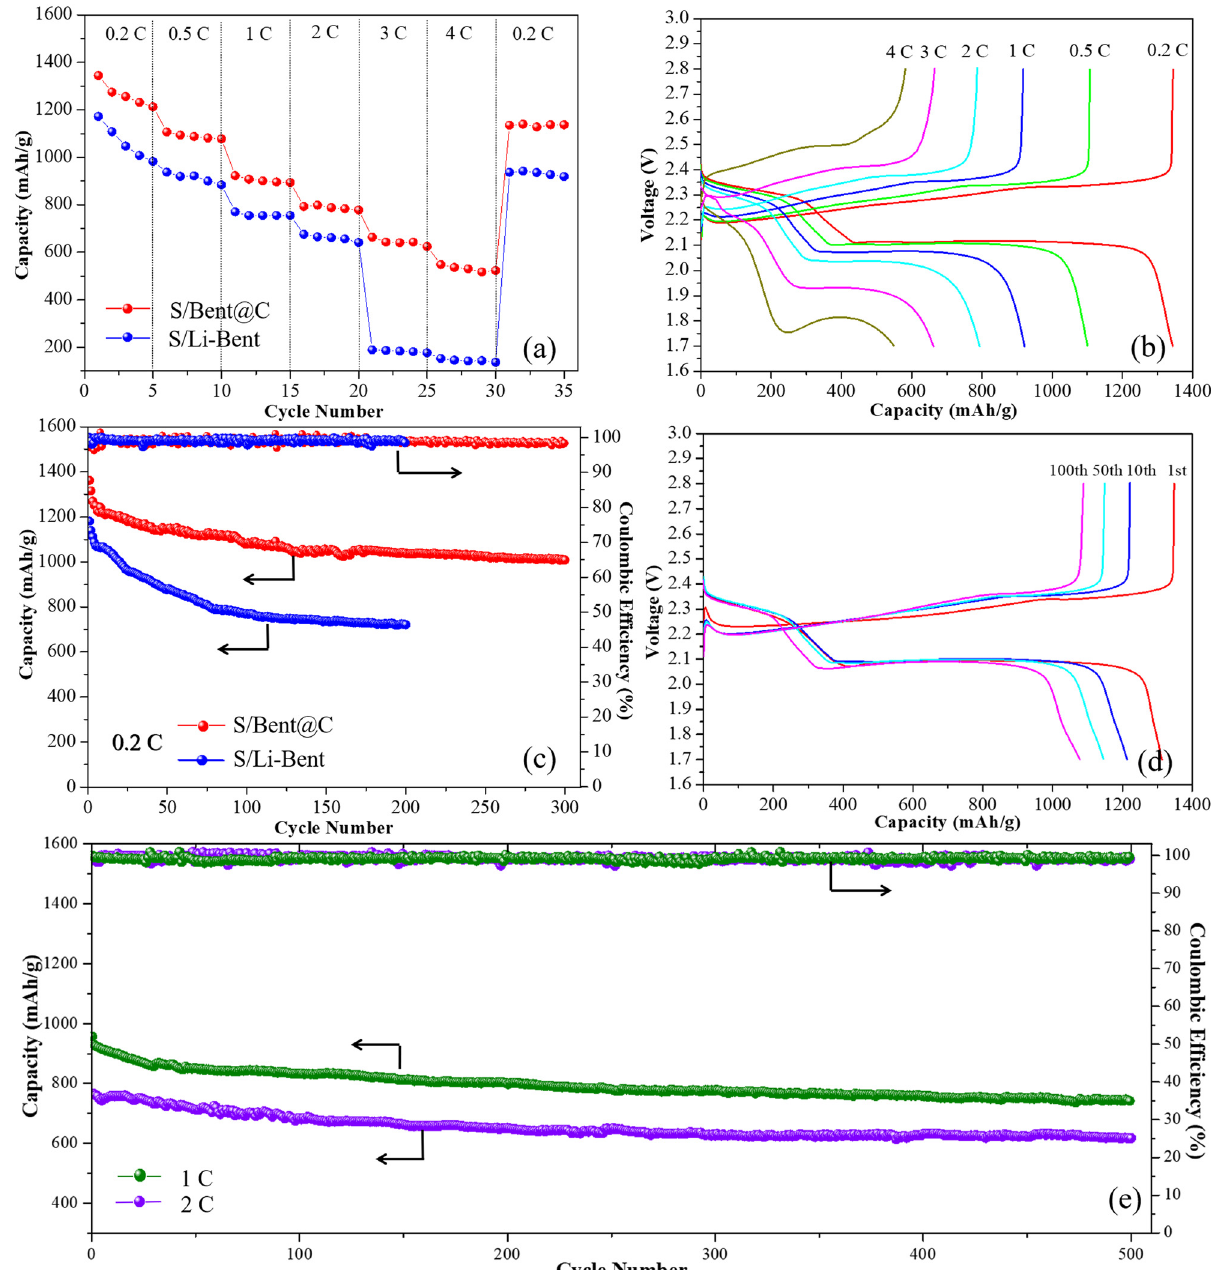
Figure 7: ( a ) Rate performances of S/Bent@C and Li - Bent/S electrodes with a sulfur loading of 1.2 mg cm − 2 . ( b ) Galvanostatic charge/ discharge pro fi les of S/Bent@C electrode with a sulfur loading of 1.2 mg cm − 2 at various C - rates. ( c ) Cycling performances of S/Bent@C and Li - Bent/S electrodes with a sulfur loading of 2 mg cm − 2 at 0.2C. ( d ) Galvanostatic charge/discharge pro fi les of S/Bent@C electrode with a sulfur loading of 2 mg cm − 2 at di ff erent cycles. ( e ) Long - term cycling performance of S/Bent@C electrode with a sulfur loading of 2 mg cm − 2 at 1 and